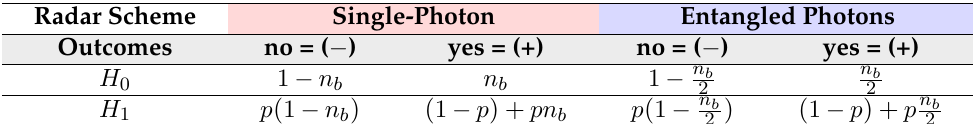
Table 1. Probabilities of error for single-shot measurements for the single-photon radar and the quantum illumination